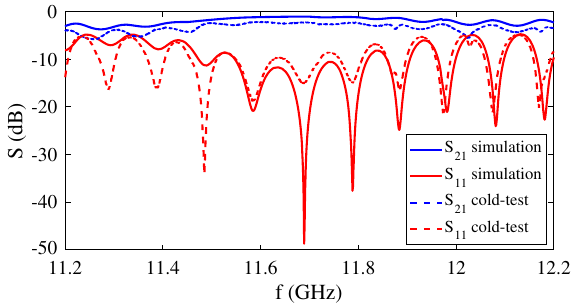
FIG. 10. Comparison of S-parameters between the cold-test measurements and the CST simulations.